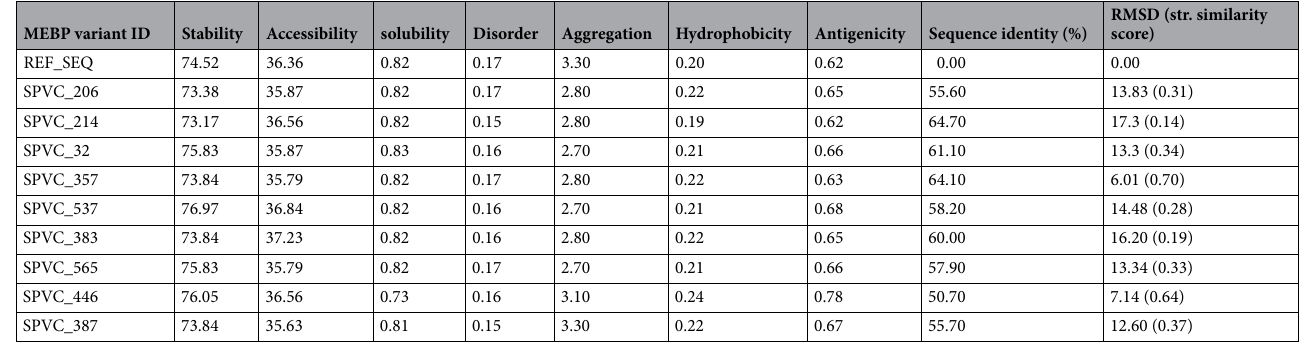
Table 4. The raw data of the Immuno- and Biophysical properties of the ten MEBP variants for ready reference.